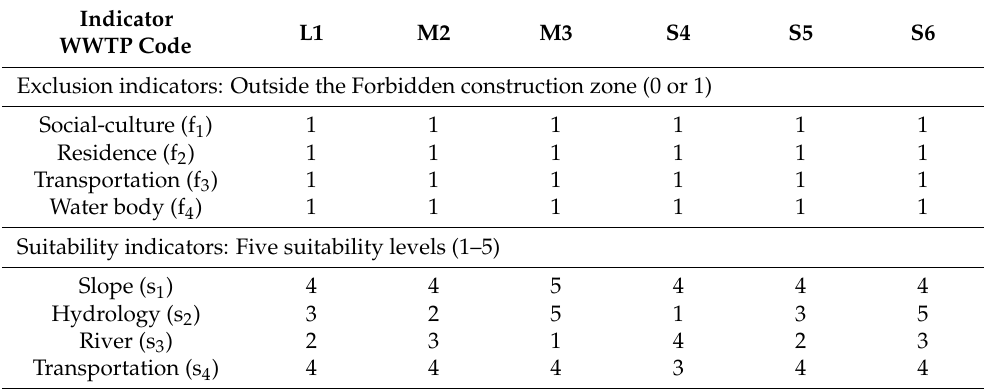
Table 8. Results Comparison between the different